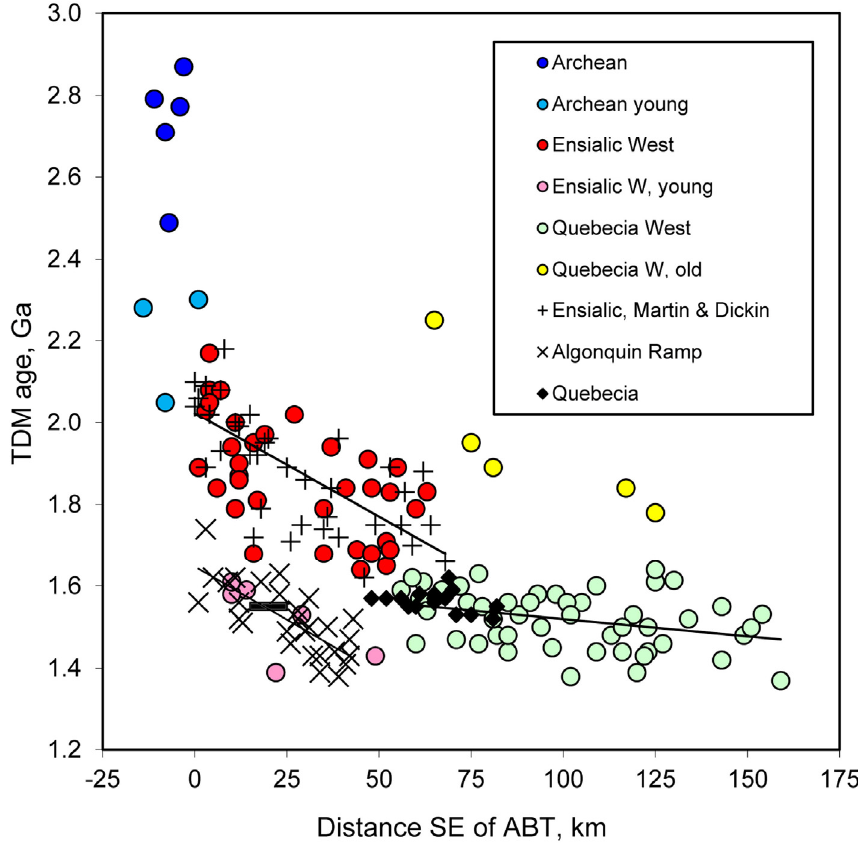
Figure 4. Plot of TDM model age versus distance SE of the ABT for samples of the present study (coloured spots), divided into the same three blocks that were identified by Martin and Dickin [4]. Linear regression fits are shown for published data (crosses) from the ensialic arc block [4] and the Algonquin ramp [20], along with new data for Western